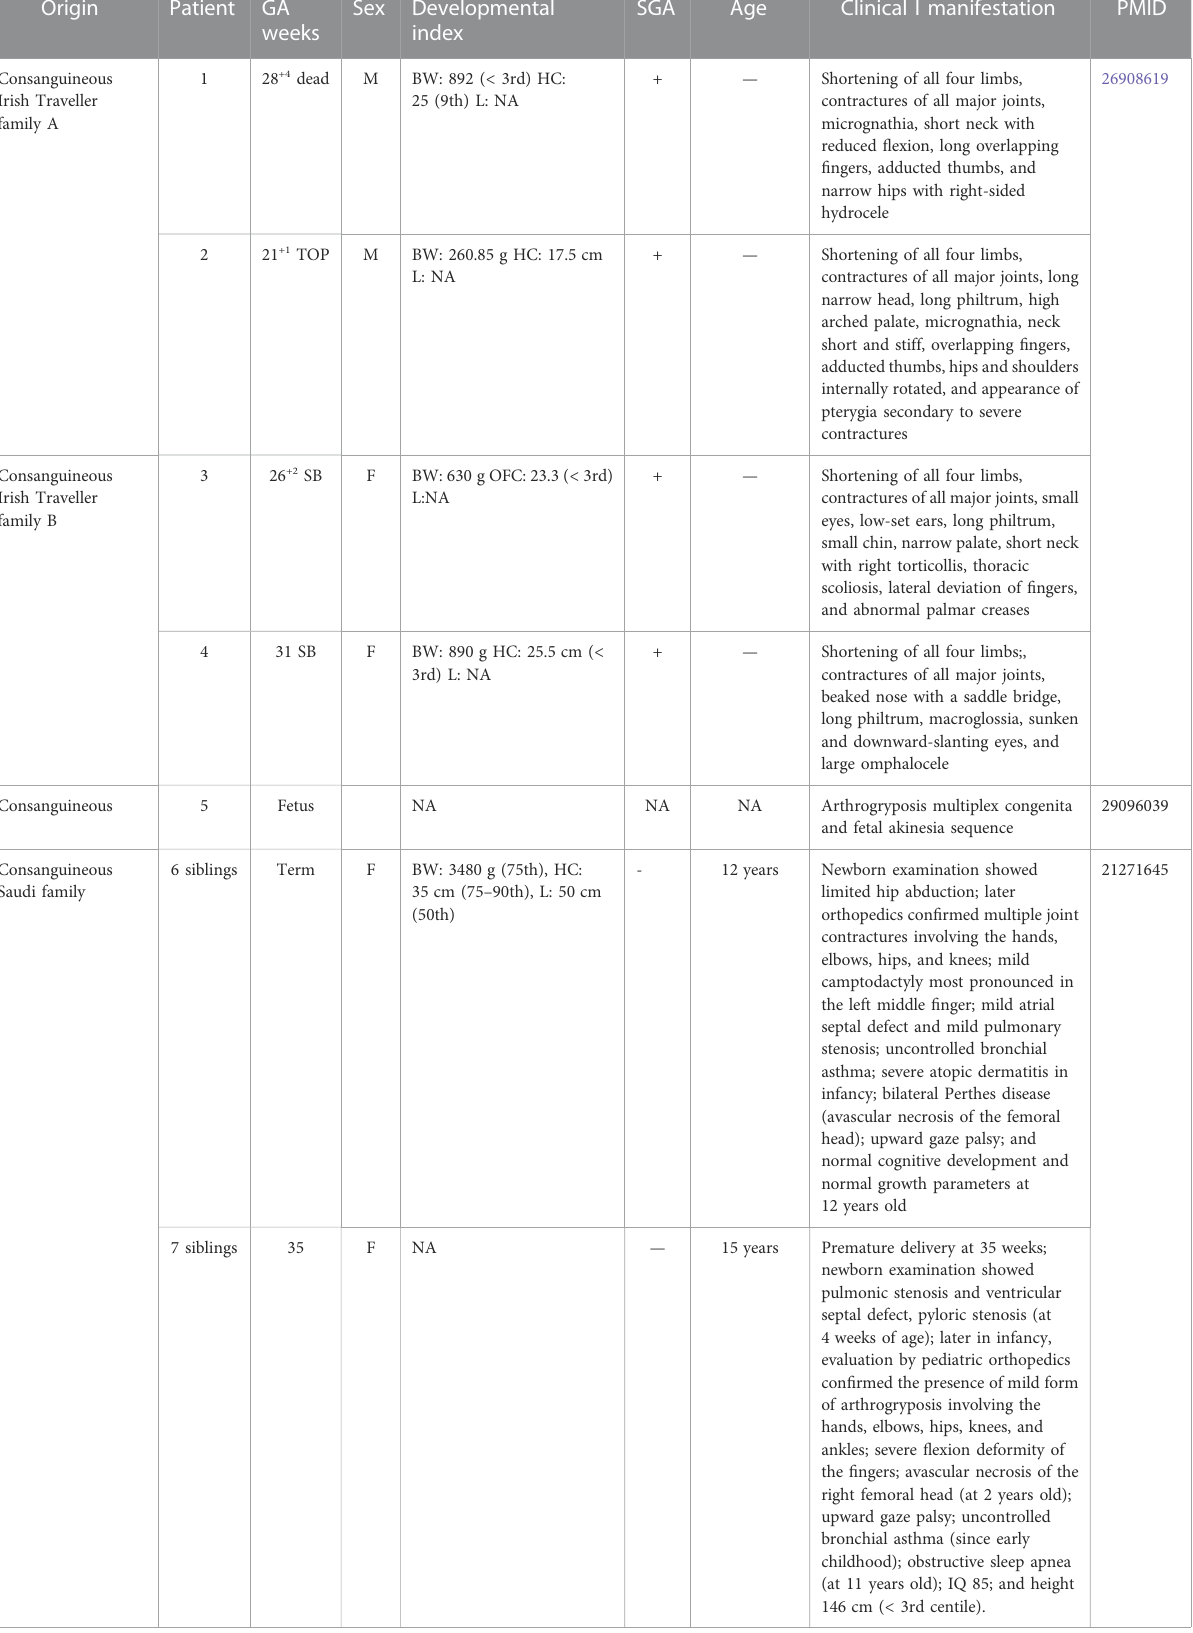
TABLE 1 Summary of phenotypic features of all reported